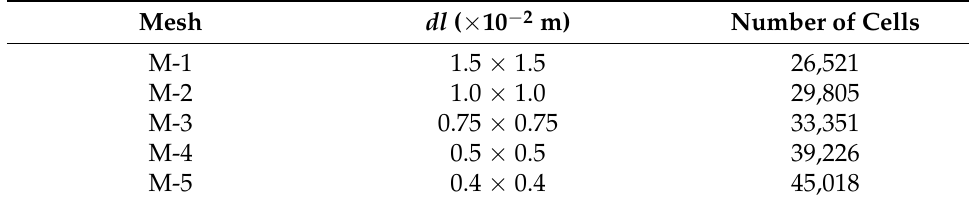
Table 1. Mesh characteristics in the mesh dependency analysis.